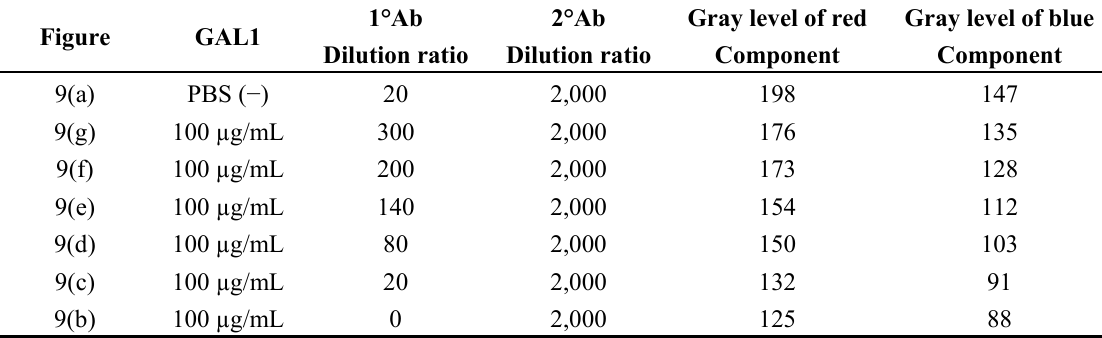
Table 1. Measurement results of ferromagnetic coded micro-carriers by image processing.